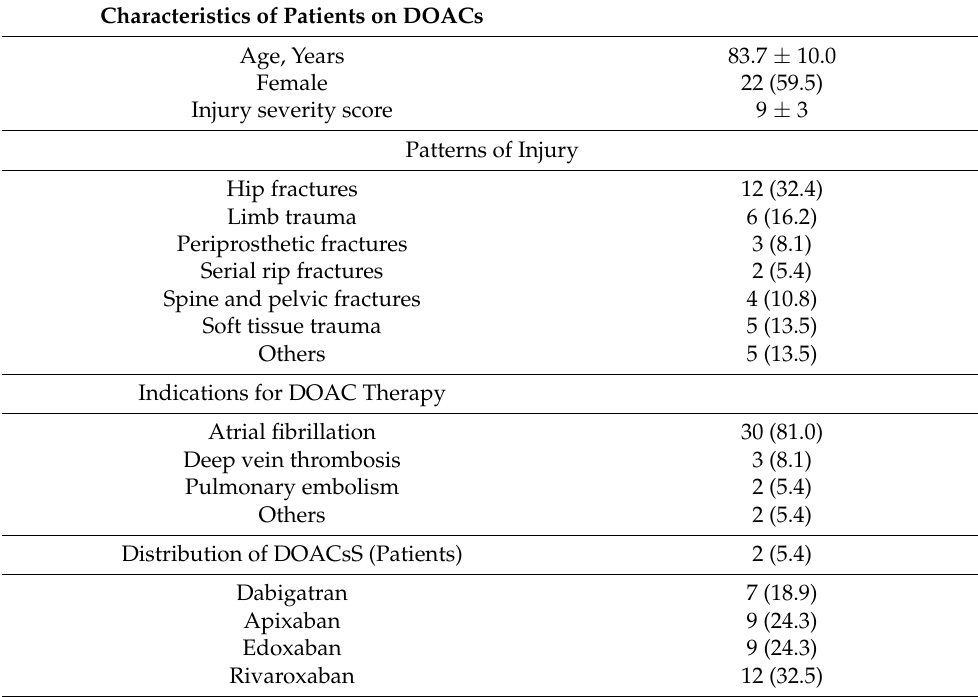
Table 1. Characteristics of patients on DOACs ( n =